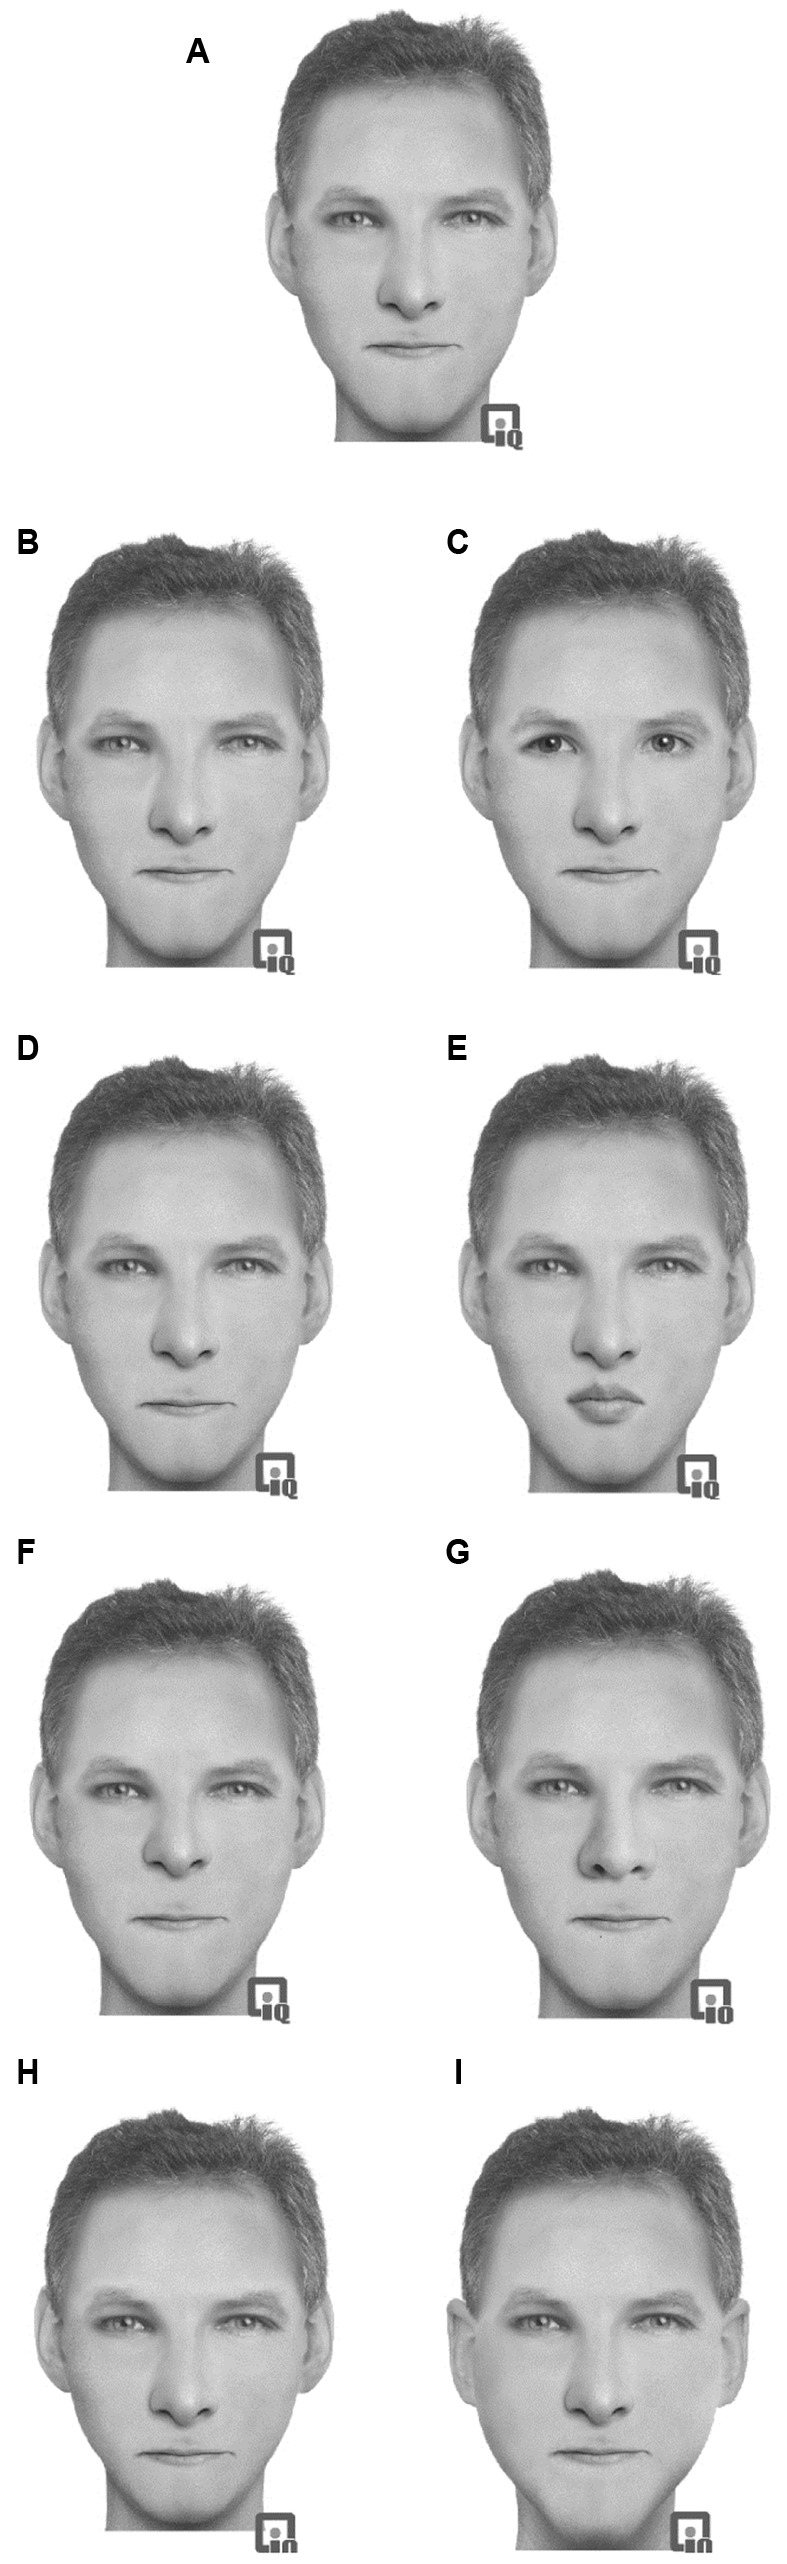
Example of the stimuli used in Experiment 2 with an original prototype (A) face with modifications: (B) eyes changed, (C) eyes replaced, (D) mouth changed, (E) mouth replaced, (F) nose changed, (G) nose replaced, (H) outer head changed, (I) outer head replaced.